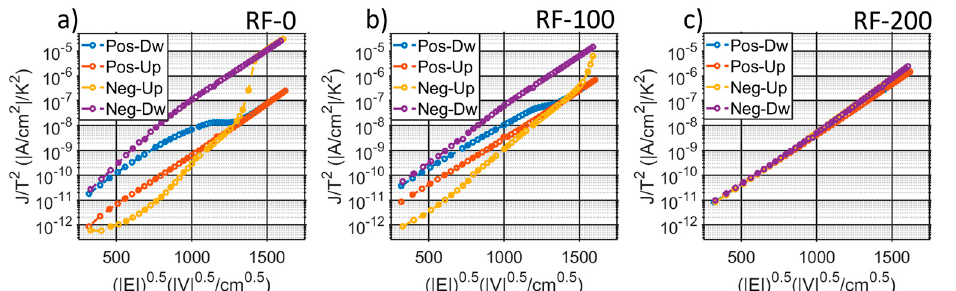
Figure 5. Example of leakage current densities for ( a ) RF-0, ( b ) RF-100, and ( c ) RF-200 measured at 25 °C and plotted versus the square root of the field to indicate the linear relationship between ln(J/T 2 ) and √ E, typical of Schottky emissions. Each leakage measurement considers the combination of bias (positive or negative) and film polarity (up or down). Figure S1 in the supplemental material summarizes the measured leakage for all the sample at three different temperatures.